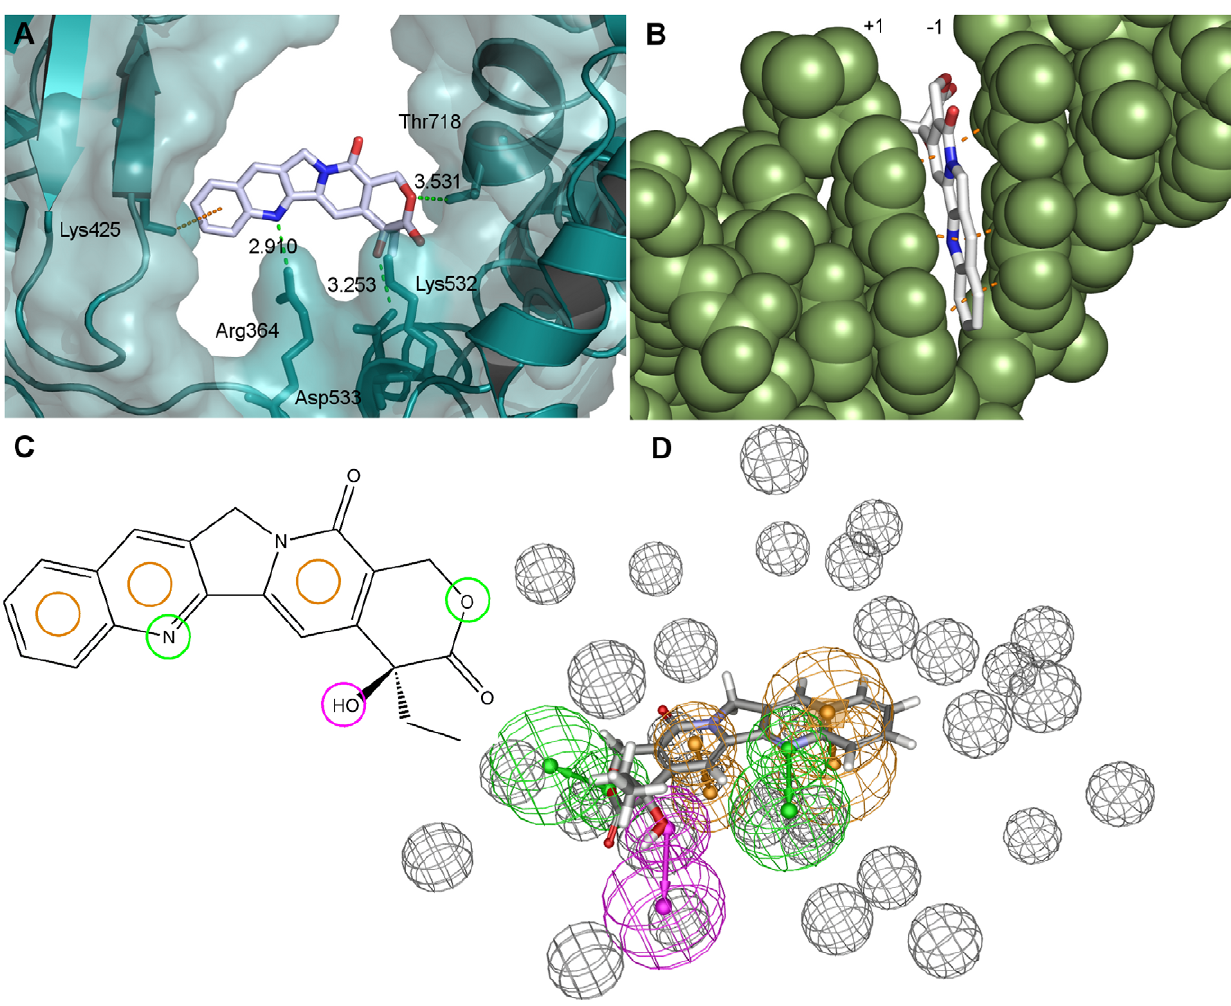
Figure 3. Structure-based pharmacophore development for camptothecins. (A) Camptothecin in the Top1 active site (from PDB file: 1T8I) viewed down the DNA helix axis. The protein backbone is shown as a solid ribbon and the protein surface in soft blue. Possible hydrogen bonds and p -interactions between camptothecin and Top1 are shown in green and orange, respectively (dotted lines), with distances between heavy atoms shown (A˚). The amino acids involved are represented as sticks. (B) DNA - camptothecin interactions. DNA shown in green in space-filling mode. Examples of p - p interactions between camptothecin and flanking DNA bases are indicated in orange (dotted lines). (C) 2D representation of the structure-based pharmacophore for camptothecins and its mapping to CPT. The pharmacophore is an intersection between the camptothecin and the topotecan pharmacophores. (D) 3D representation of the pharmacophore used in database screening. Features and camptothecin colours are represented as in Figure 2.